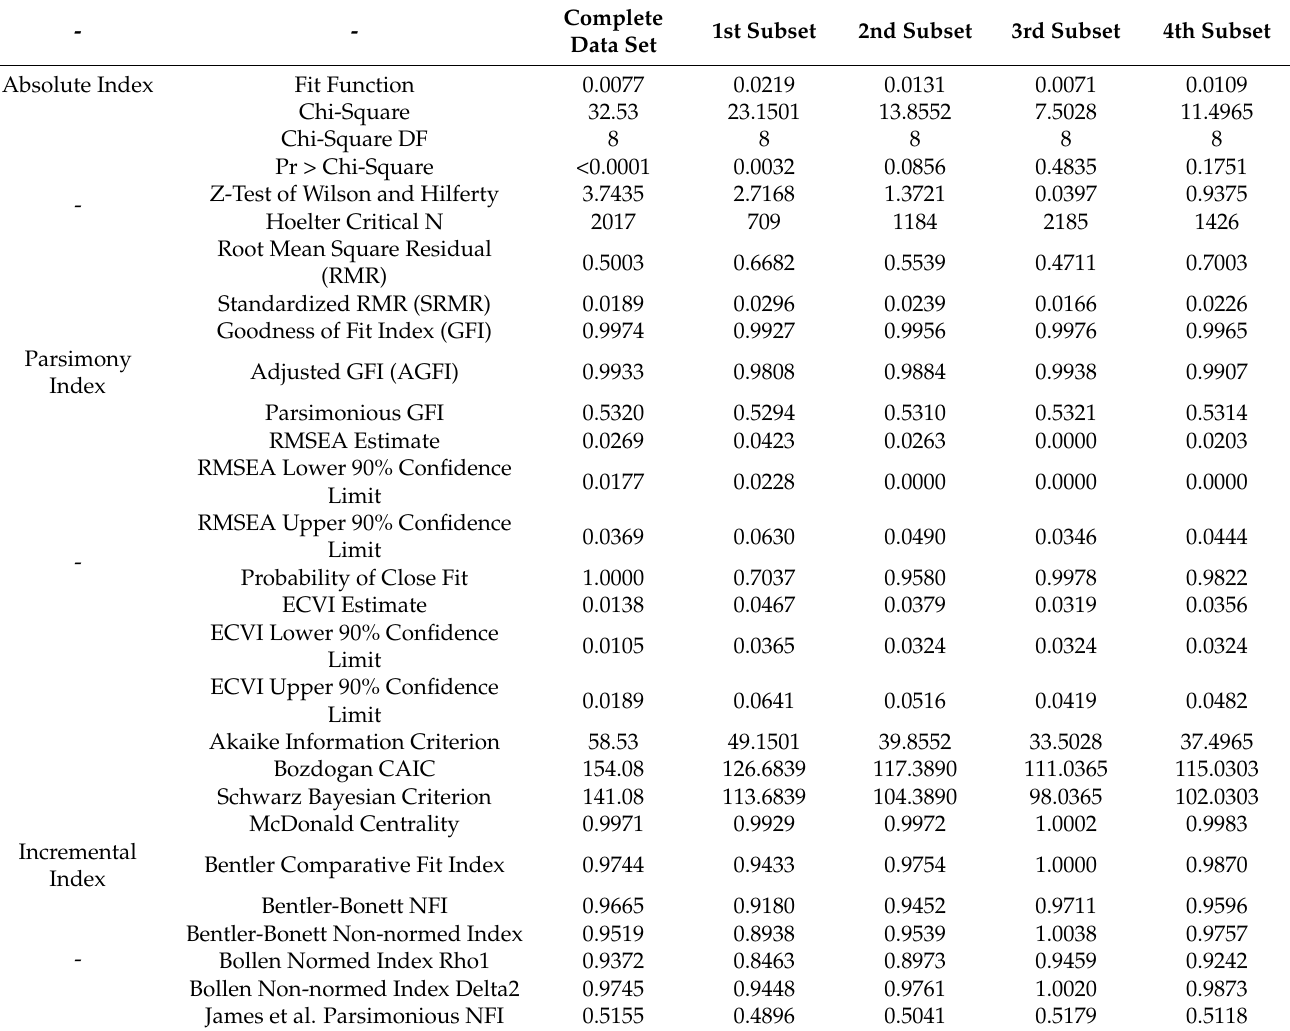
Table 12. Results with different data